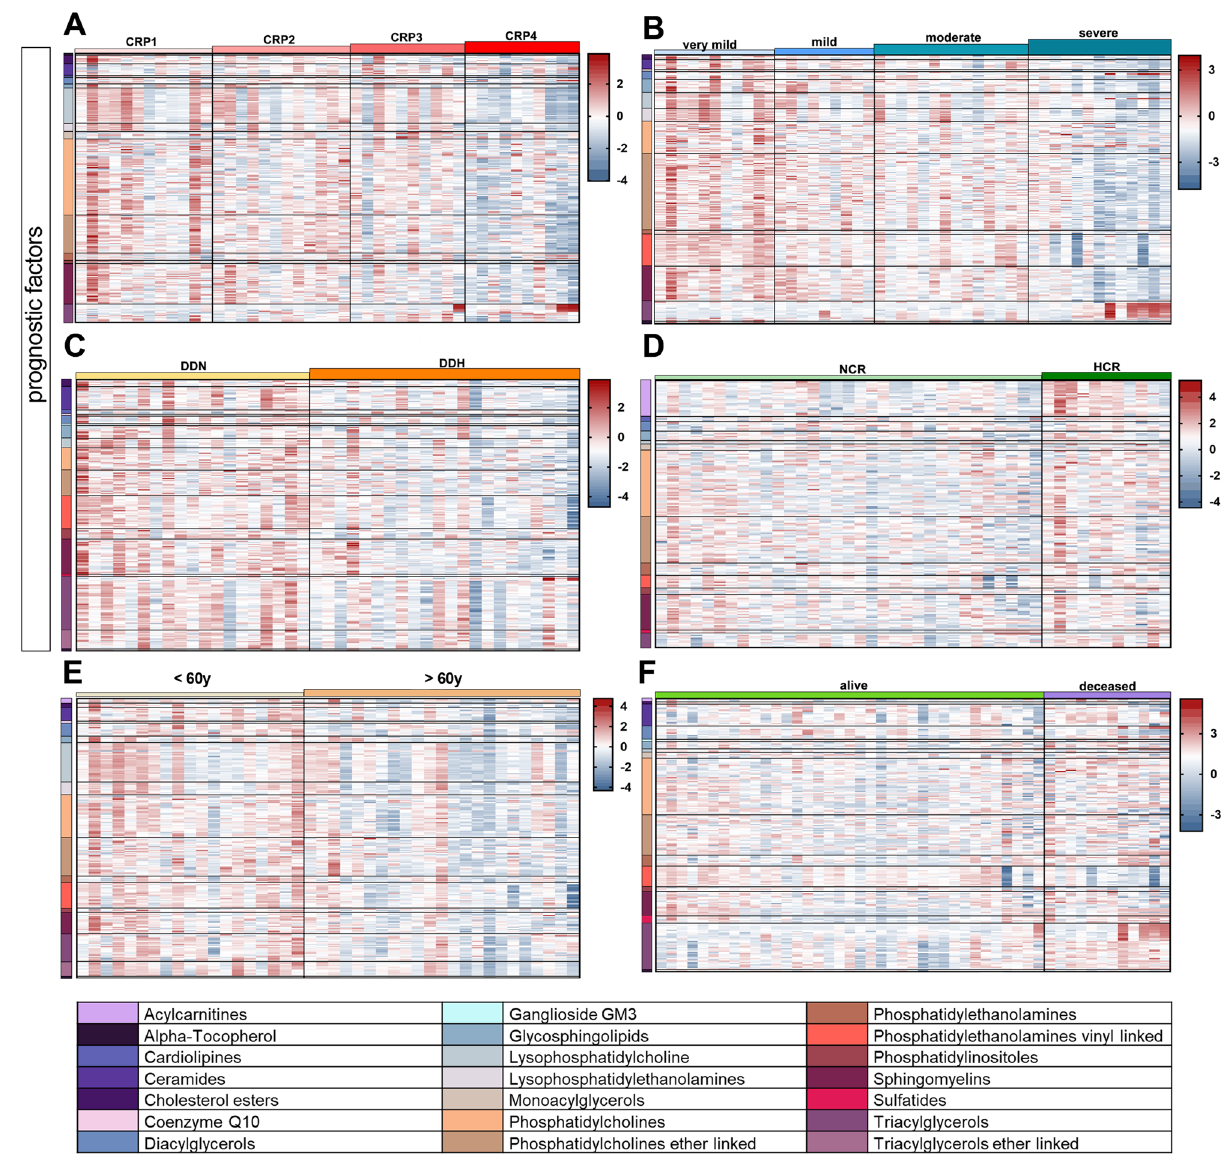
Figure 4. Heatmaps of the lipids highly correlated with each prognostic factor—( A ) inflammation, ( B ) hypoxia, ( C ) coagulation state, ( D ) kidney function and ( E ) age—and with the outcome ( F ) chosen within those with a Variance Importance in Projection (VIP) score superior than 1.5, ordered by lipid